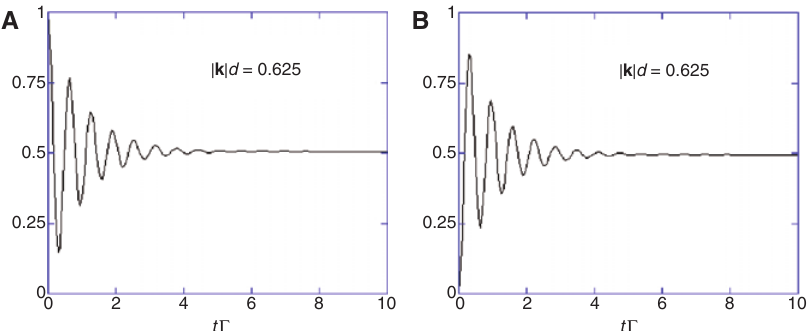
Figure 6: The time evolution of the excitation in the surface polariton mode for a fixed momentum parallel to the surface. Plot of (A) 〈 a † a 〉/ n and (B) 〈 b † b 〉/ n as a function of time t Γ for the modes with wavevector component | k | d = 1 1